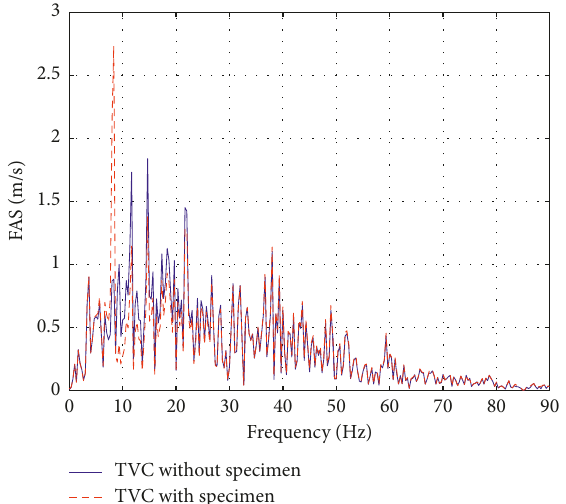
Figure 15: Acceleration Fourier amplitude spectrum of the dual shaking tables without/with specimen under TVC.